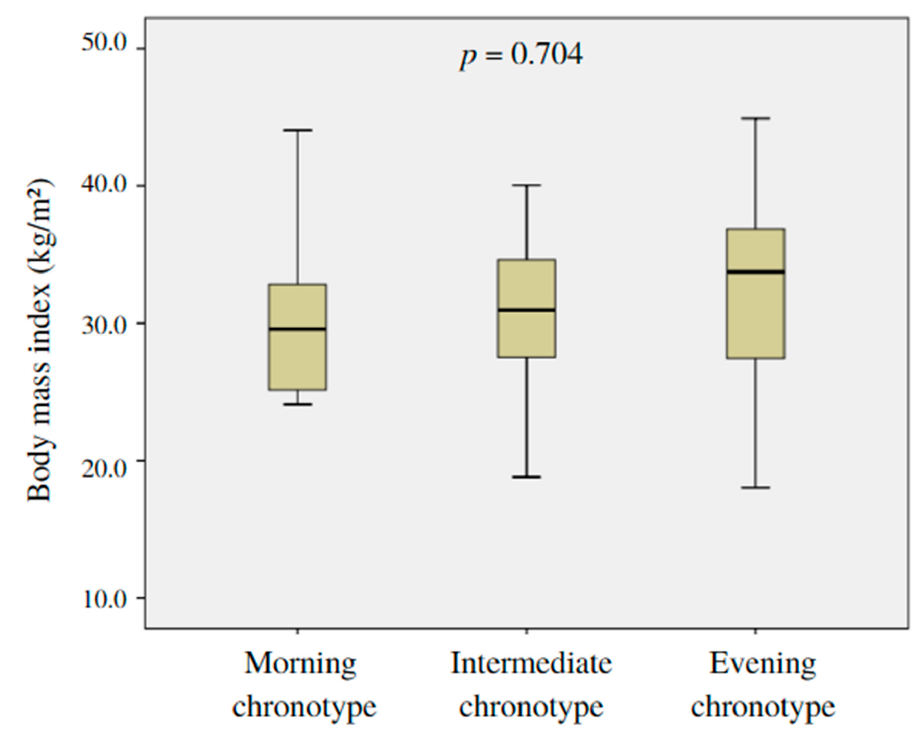
Figure 2. Mean body mass index according to chronotype categories.